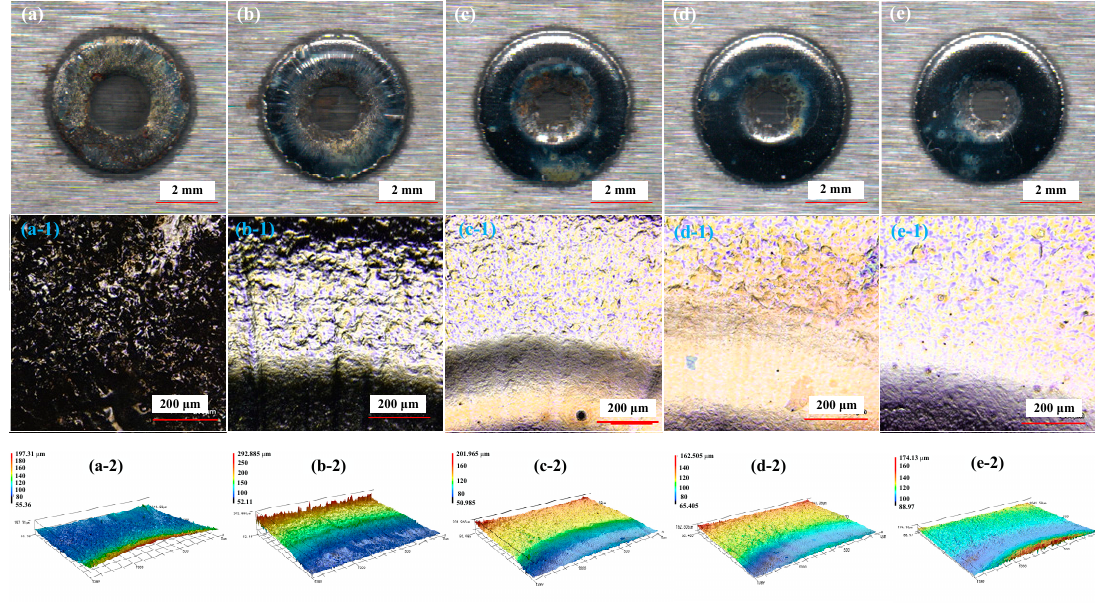
Figure 18. Surface morphology of workpiece at different current density in NaNO 3 electrolyte: ( a ) 300 g/L, 10 A/cm 2 ; ( b ) 300 g/L, 20 A/cm 2 ; ( c ) 300 g/L, 30 A/cm 2 ; ( d ) 300 g/L, 40 A/cm 2 ; ( e ) 300 g/L, 50 A/cm 2 . Micromorphology of workpiece local surface: ( a-1 ) 300 g/L, 10 A/cm 2 ; ( b-1 ) 300 g/L, 20 A/cm 2 ; ( c-1 ) 300 g/L, 30 A/cm 2 ; ( d-1 ) 300 g/L, 40 A/cm 2 ; ( e-1 ) 300 g/L, 50 A/cm 2 . 3D profile of workpiece local surface: ( a-2 ) 300 g/L, 10 A/cm 2 ; ( b-2 ) 300 g/L, 20 A/cm 2 ; ( c-2 ) 300 g/L, 30 A/cm 2 ; ( d-2 ) 300 g/L, 40 A/cm 2 ; ( e-2 ) 300 g/L, 50 A/cm 2 .